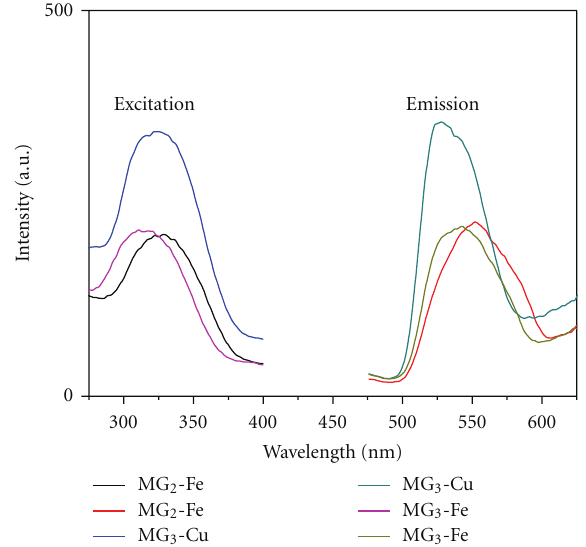
Figure 16: Excitation and emission spectra of MG 2 -Fe, MG 3 -Cu, and MG 3 -Fe taken at room